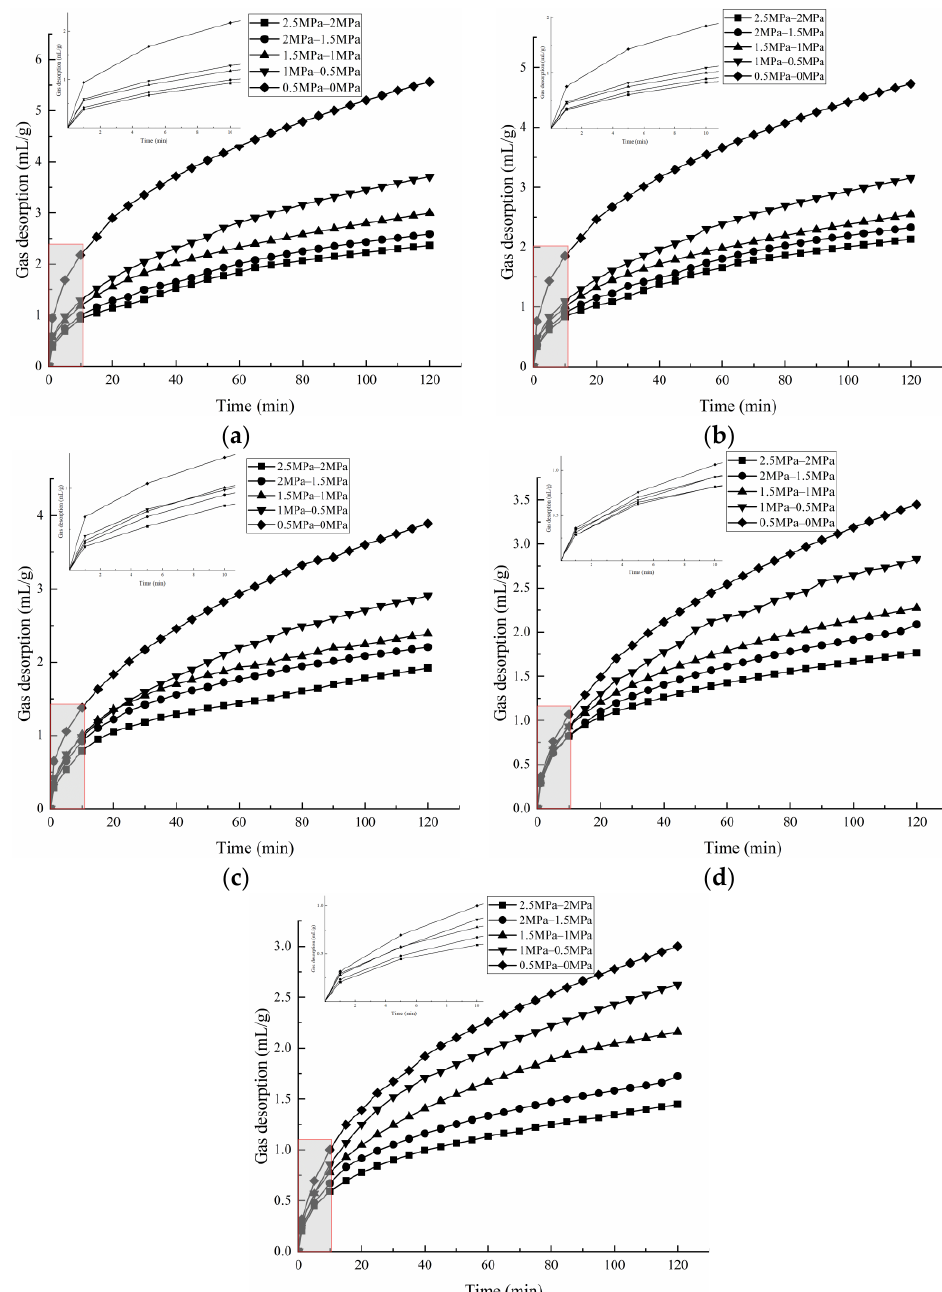
Figure 5. Gas desorption capacity in different stages of depressurization and desorption of distinct moisture. ( a ) Desorption with moisture 0%. ( b ) Desorption with moisture 1.37%. ( c ) Desorption with moisture 3.63%. ( d ) Desorption with moisture 4.56%. ( e ) Desorption with moisture 7.44%.